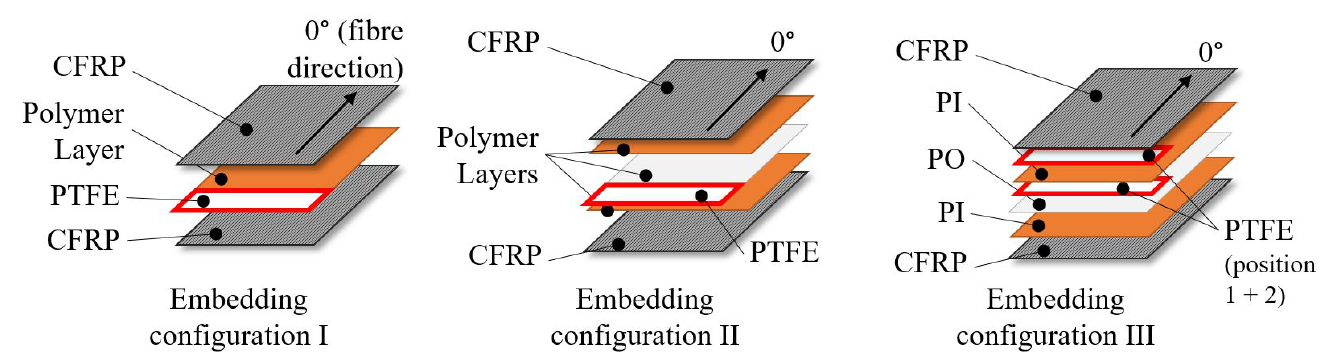
Figure 1. Illustration of investigated embedding